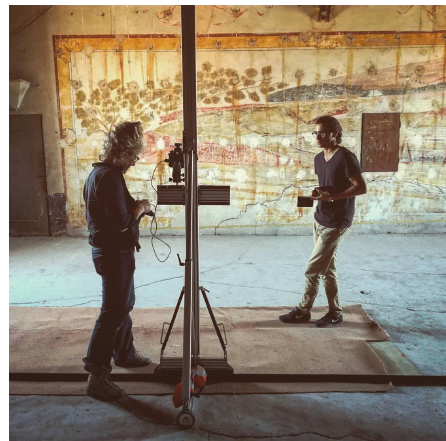
Figure 6: In-situ view of the data acquisition set-up during Anamorphosis case-study survey